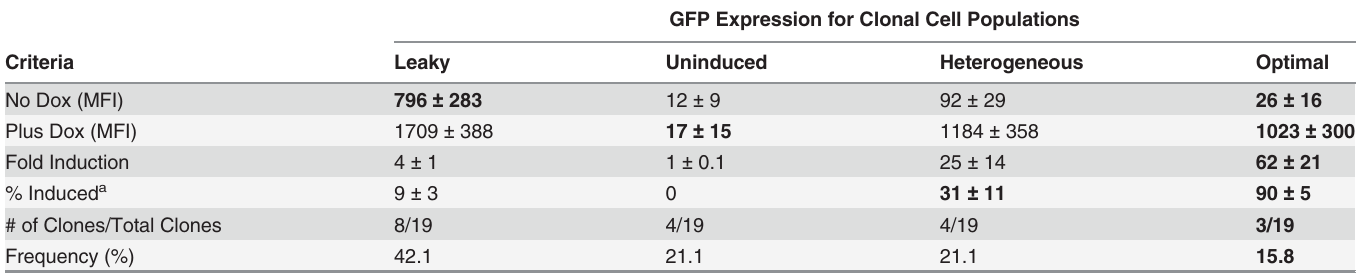
GFP Expression for Clonal Cell Populations